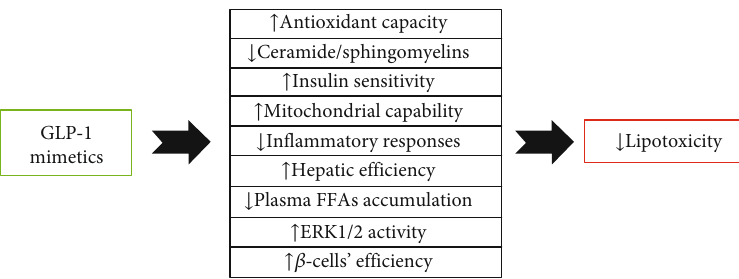
Figure 2: The antilipotoxicity e ff ects of GLP-1